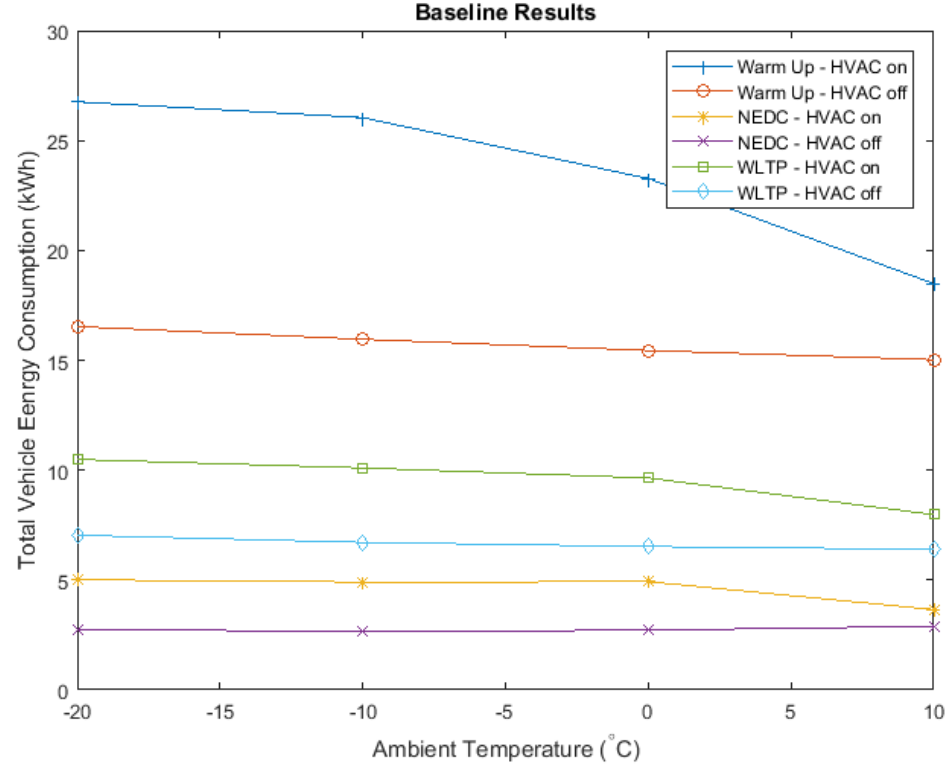
Figure 5. Energy consumption used when the vehicle completed drive cycles at different temperatures with heating on and